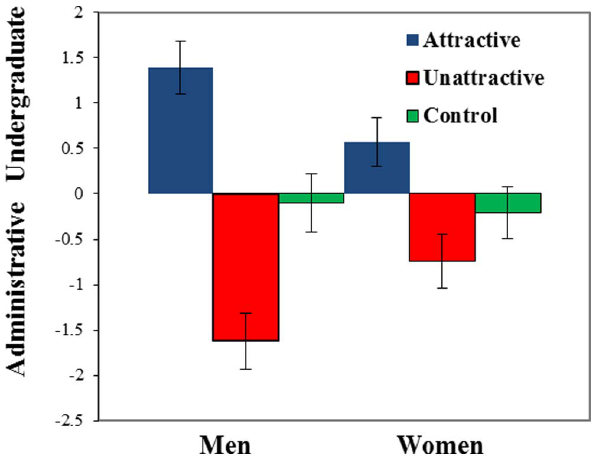
Figure 1. Flaunting and concealing as a function of sex and partner. Note. 0 represents no location preference and is considered neutral (4 on the 7-point location preference scale). We calculated preference for undergraduate or administrative location by subtracting the participants’ scores by 4 (no location preference). Bars represent standard errors.